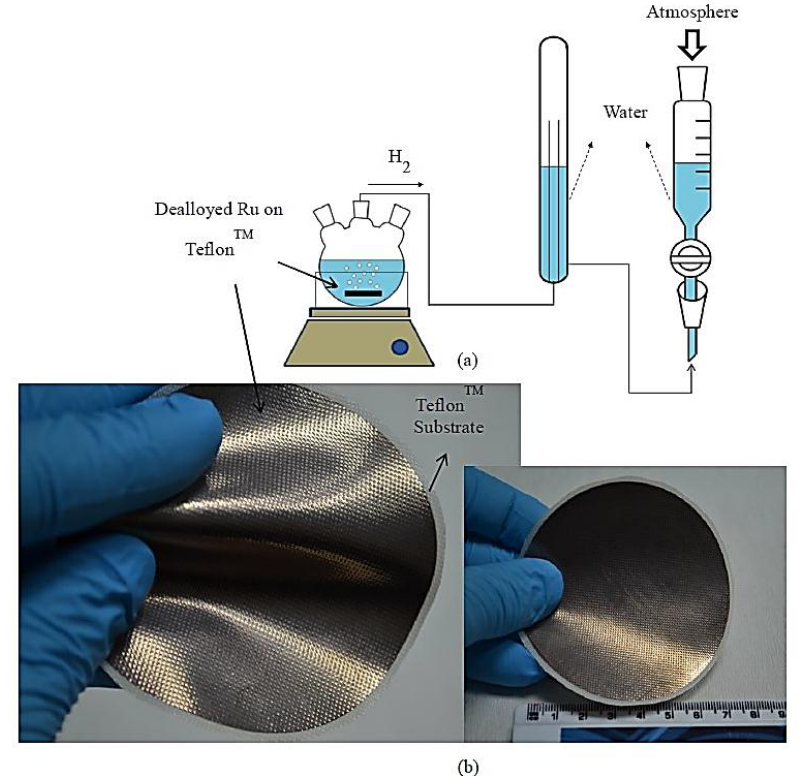
Figure 1. ( a ) Hydrogen generation measurement system; ( b ) Dealloyed Ru catalyst on Teflon™ substrate.